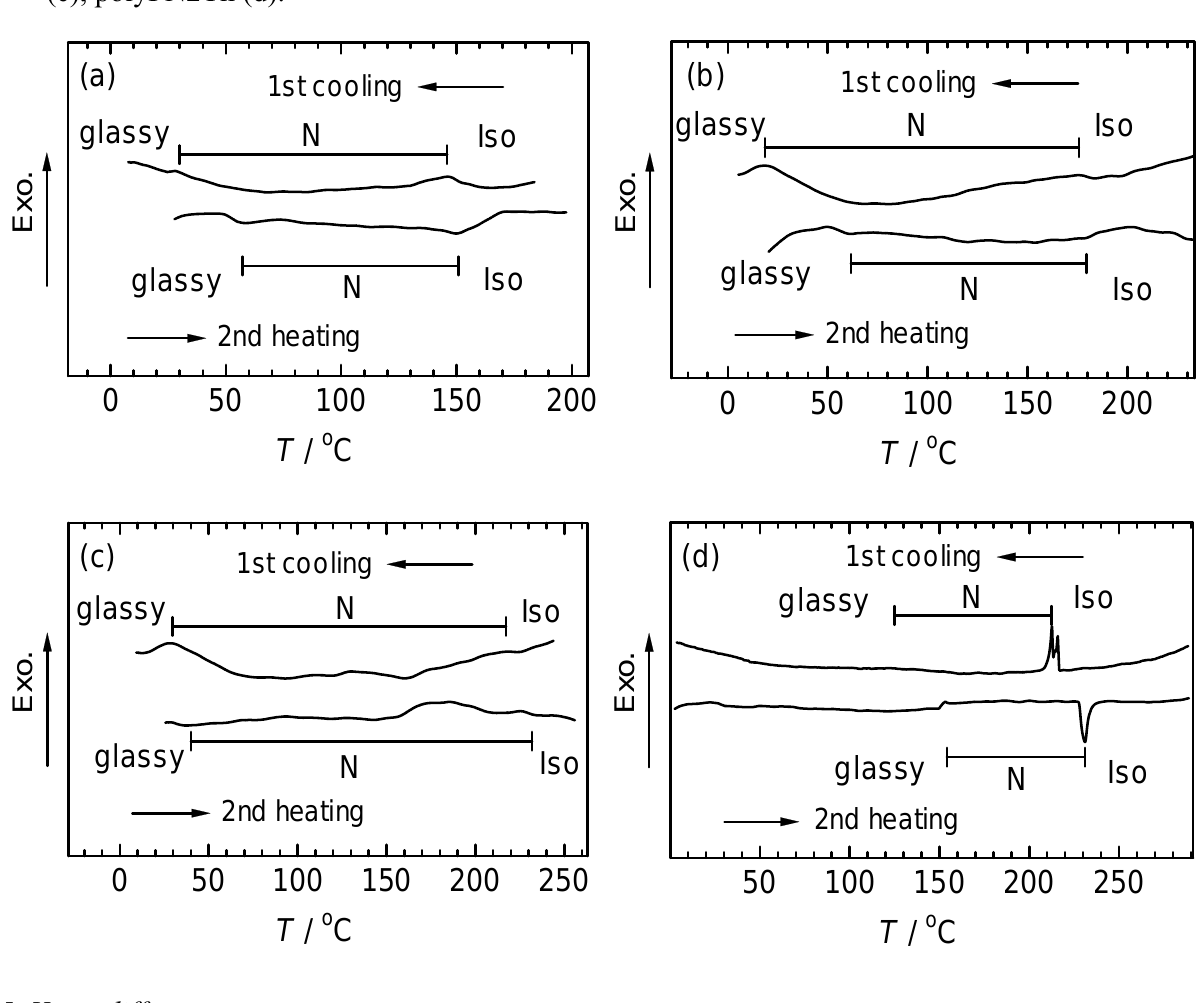
Figure 9. DSC curves of the polymers. PolyPLCTh (a), polyPLC2Th (b), polyPLC3Th (c), polyPN2Th